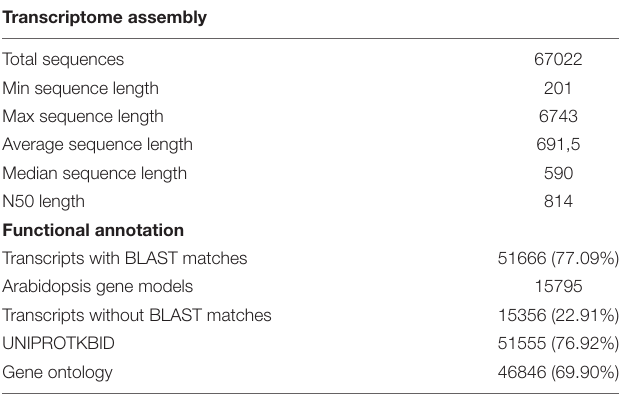
TABLE 1 | Summary statistics of the sequence assembly and functional annotation for Hypericum perforatum ovule transcriptome. Transcriptome assembly